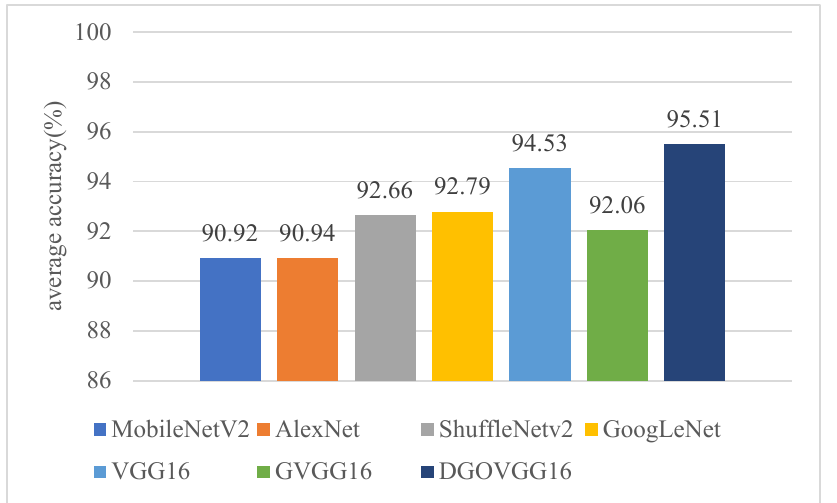
Figure 6. Classification accuracy comparison for different models on the furniture dataset.